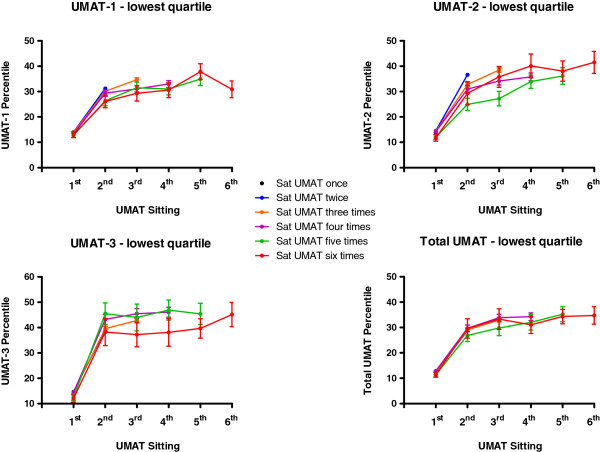
Total UMAT percentile score and percentile score in each of its 3 subsections (± SEM) by number of times candidates re-sat the test between 2000 and 2012 for those in the lowest performance quartile in their first test. Error bars are absent where they are too small relative to the mean.